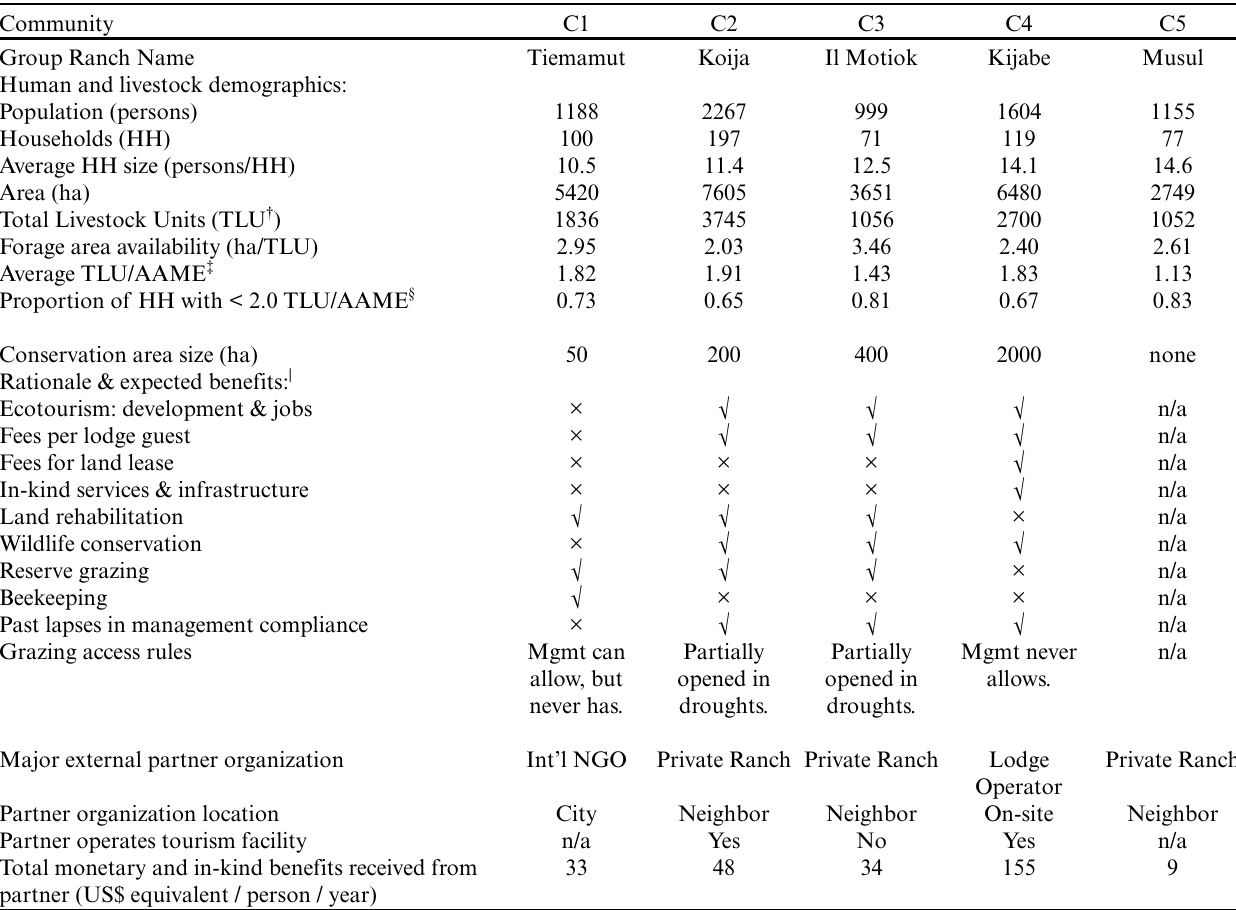
Table 1 . Characteristics of community demographics, conservation areas, and external partner organizations.